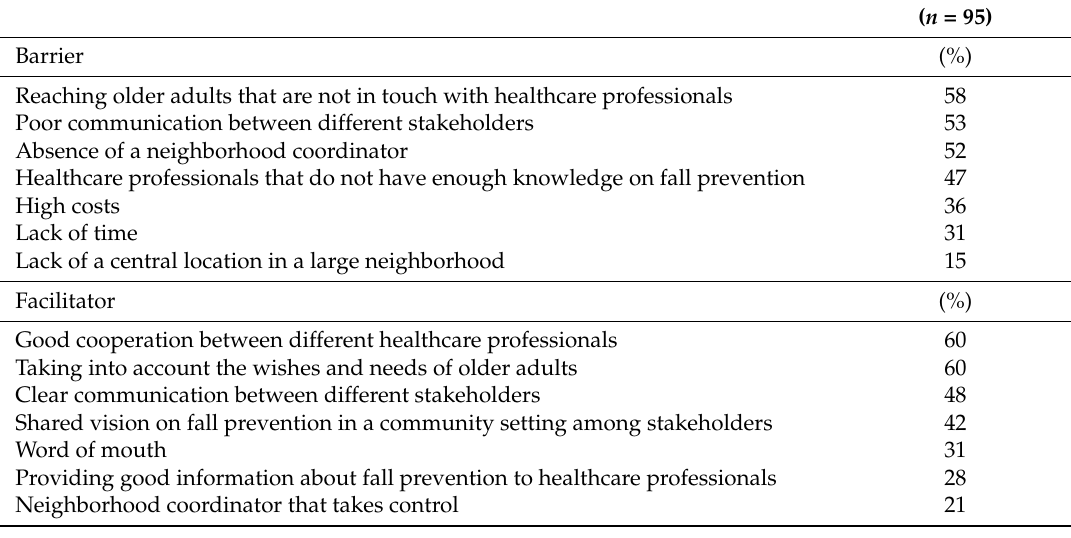
Table 2. Barriers and facilitators according to healthcare professionals in organizing fall prevention in a community